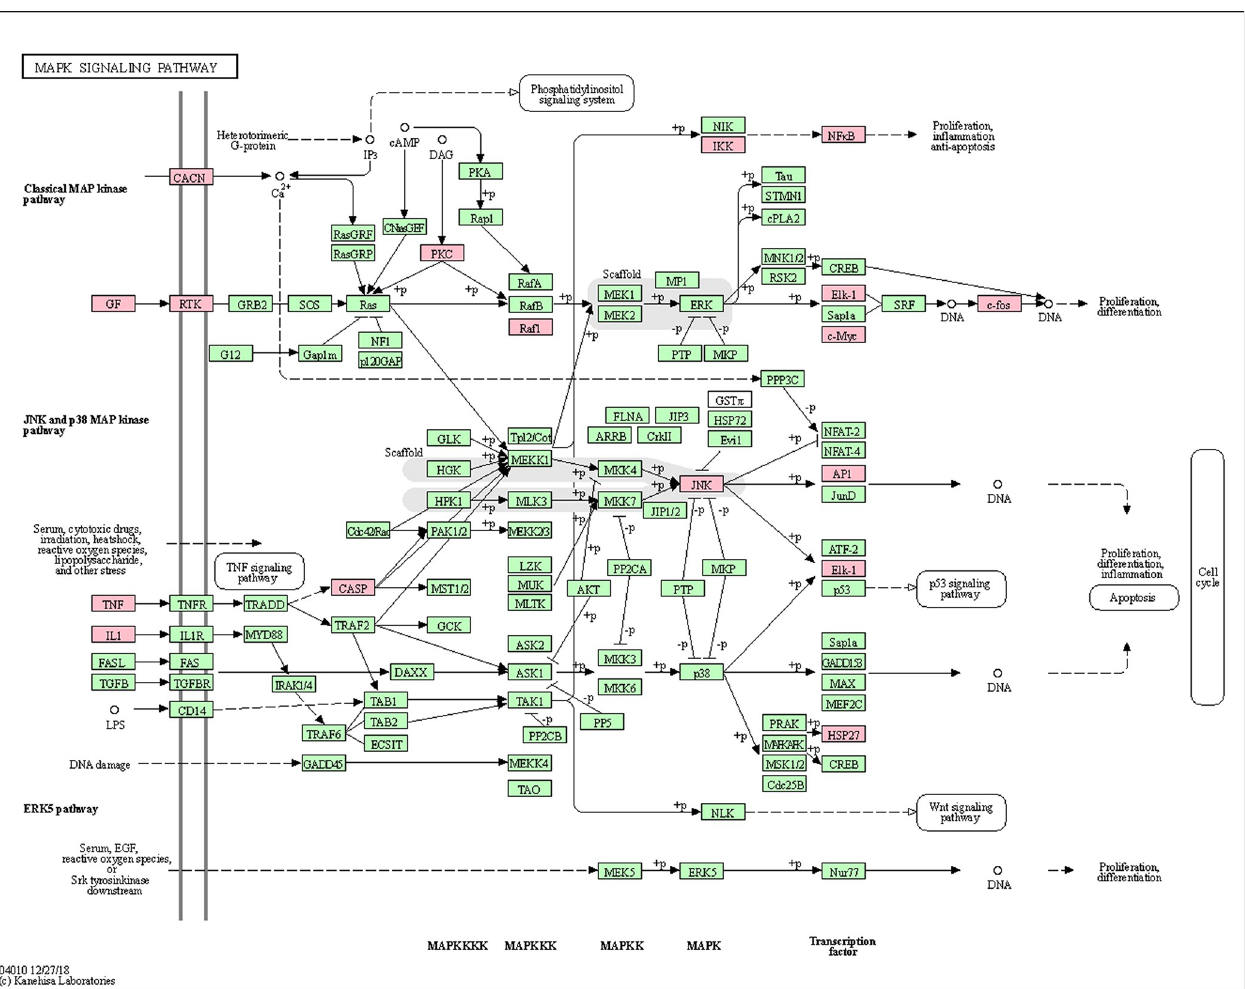
Fig 9. MAPK signaling pathway. The red rectangle represents the targets related to the core component-target-pathway network.